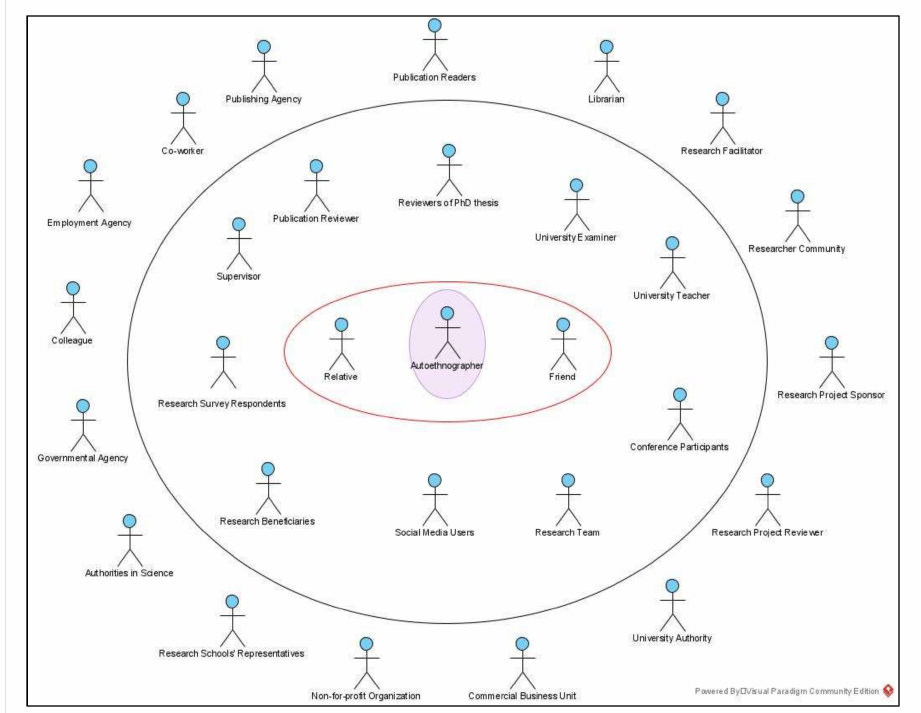
Figure 7. Autoethnographer in the center of communication with other stakeholders. Figure 7 present author’s original communication model. Autoethongrapher in